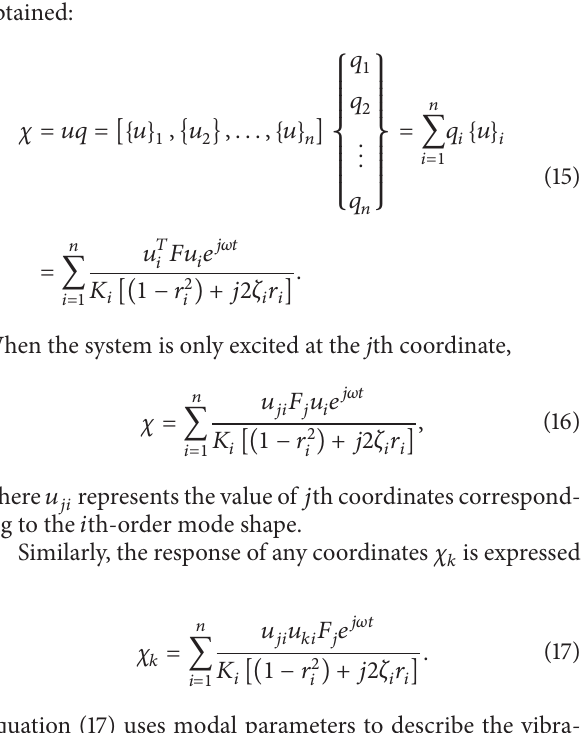
Table 1: The fore ten modes of